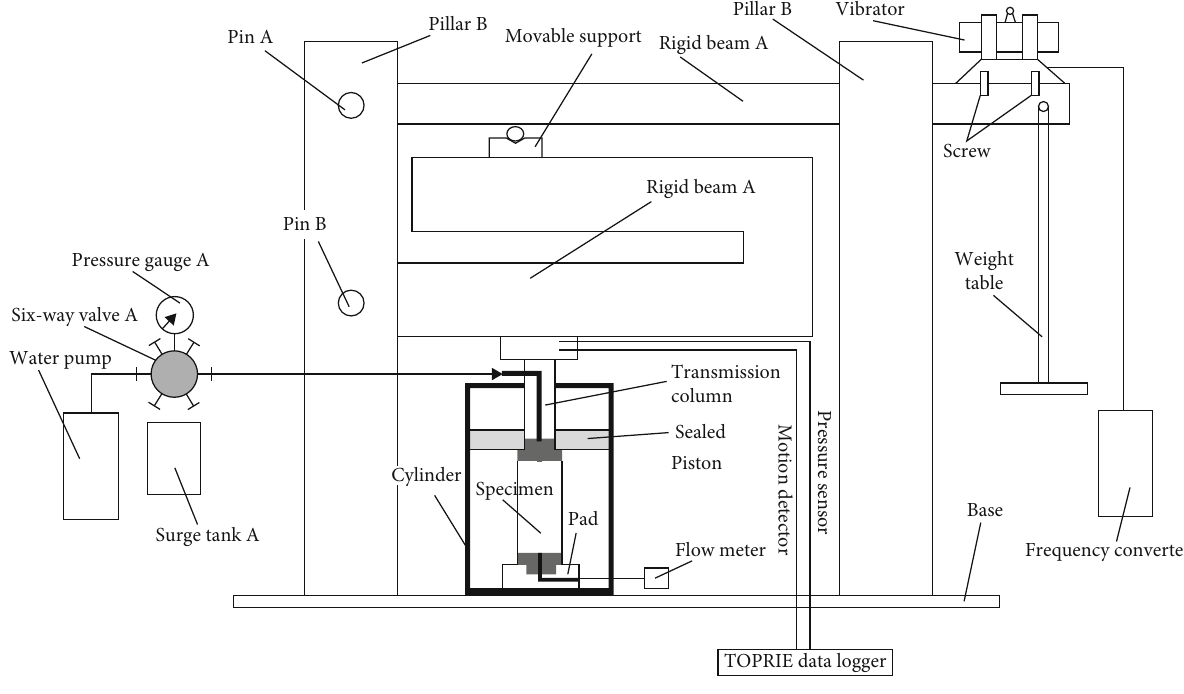
Figure 1: Percolation-perturbation creep test bed. Table 1: Test